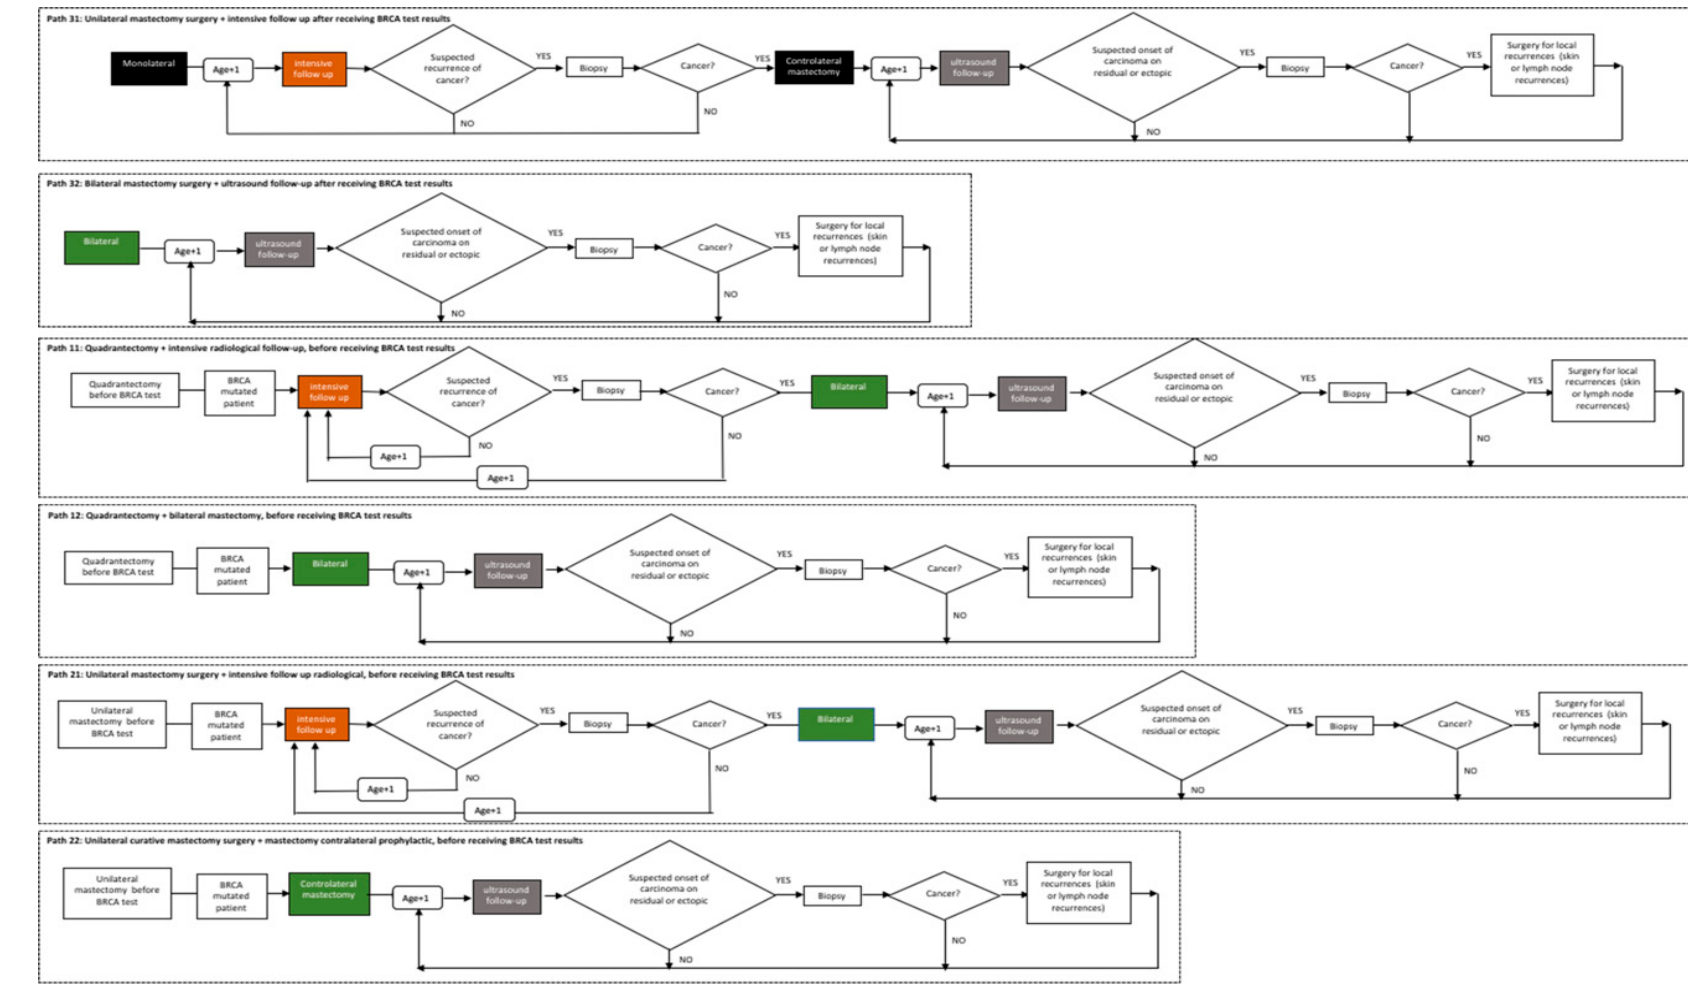
Figure A1. Description of therapeutic paths for patients with BRCA-mutated breast cancer.